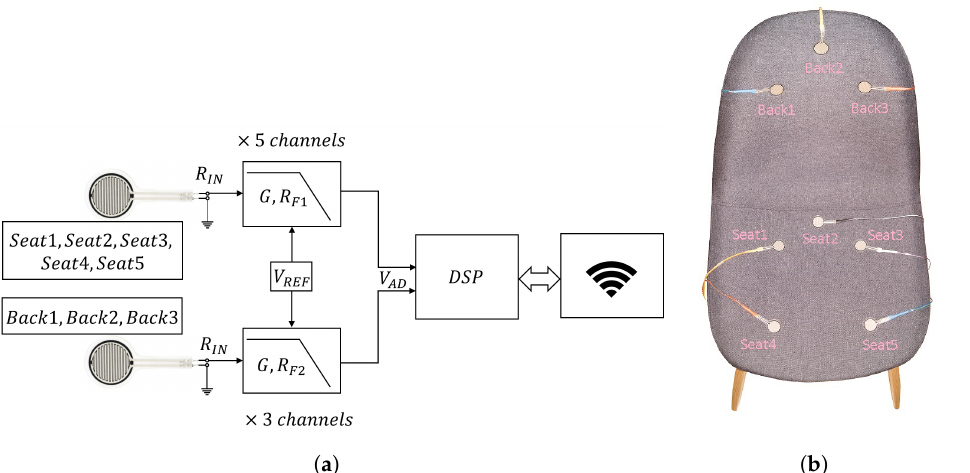
Figure 2. The Smart Chair sensors system: ( a ) block diagram of the sensors system circuit. Analog front-end has seat and backrest circuits that convert the sensors signals R IN to voltage. DSP converts the analog voltage signals to digital data packets. Wi-Fi module transmits the TCP packets to the computer; ( b ) top view of the chair equipped with labeled FSR